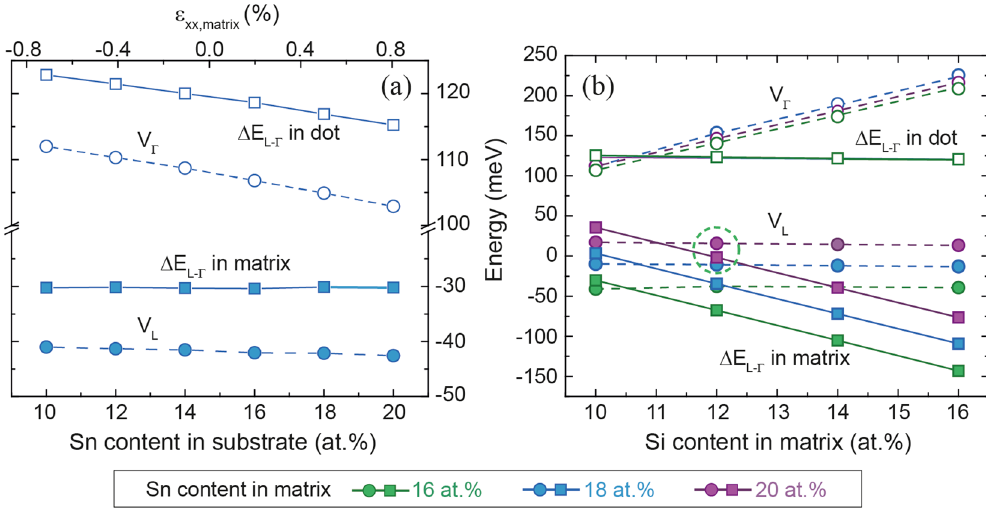
Figure 10. Influence of strain/Sn content in the substrate ( a ) and different Si/Sn contents in the SiGeSn matrix ( b ) on band discontinuities for Γ - (dashed lines, empty circles) and L-valley (dashed lines, solid circles) and directness Δ E L- Γ in the matrix (solid lines, solid squares) and dot (solid lines, empty squares), in a Ge 0.82 Sn 0.18 / Si 0.10 Ge 0.74 Sn 0.16 QD with 10 at.% in the